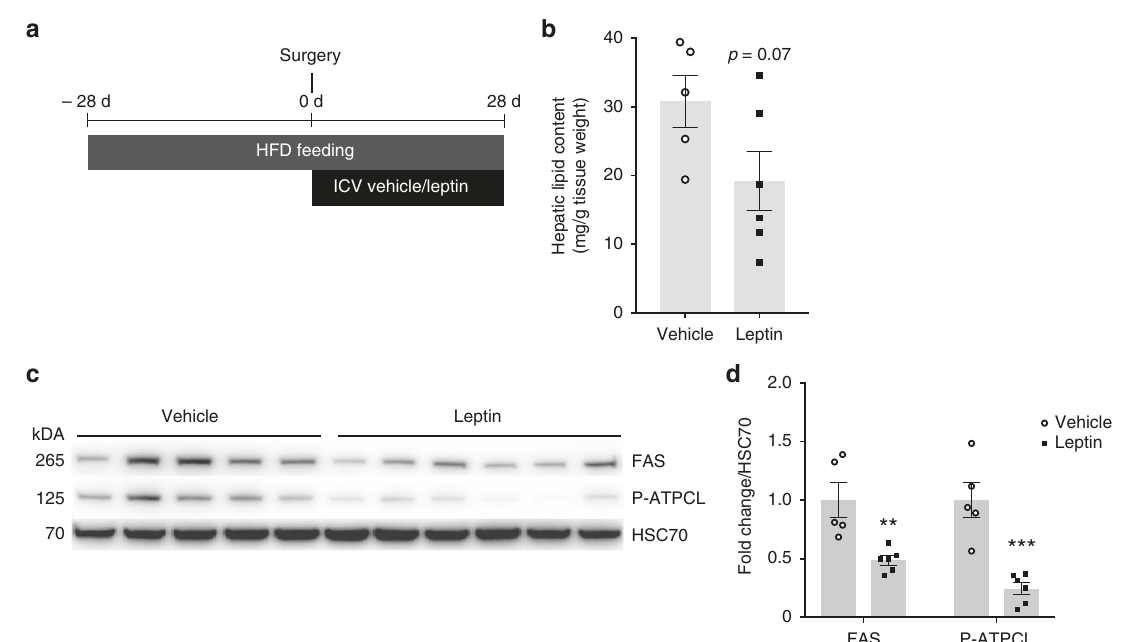
Fig. 5 Brain leptin signaling has preserved anti-steatotic effects in obese animals. a Study timeline of HFD feeding combined with the chronic ICV leptin/ vehicle infusion protocol. Note that we used a 3-time higher ICV leptin dose compared to previous experiments on regular chow (Fig. 1f). b Hepatic lipid content after 8 weeks of HFD feeding with ICV leptin/vehicle infusion during the last 4 weeks ( n ≥ 5 per group). c Western blot analyses of liver tissue lysates ( n ≥ 5 per group). d Quanti fi cation of the Western blot analyses in Fig. 5c. All data are mean ± SEM; ** p < 0.01; *** p < 0.001; vs. vehicle by two- tailed Student ’ s t test; open circles: ICV vehicle; black squares: ICV